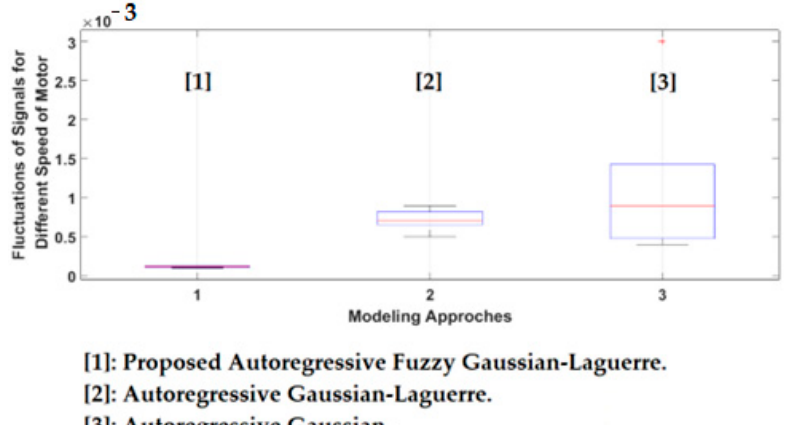
Figure 8. Robustness and stability of RMS signal modeling using the proposed autoregressive fuzzy Gauss–Laguerre algorithm, autoregressive Gauss–Laguerre technique, and autoregressive Gaussian method for normal conditions.